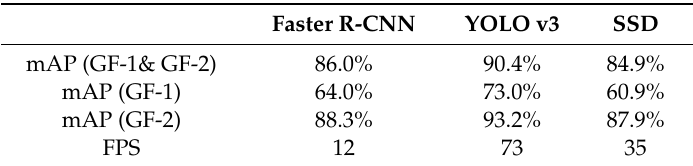
Table 3. Metrics comparison of di ff erent